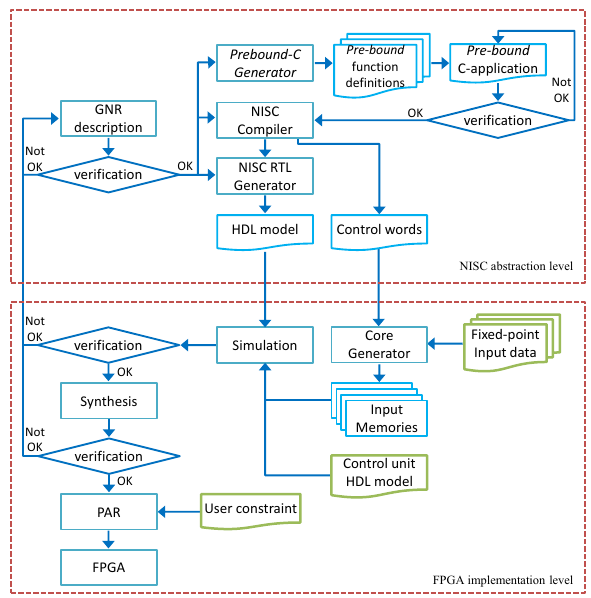
Figure 7. Adopted design